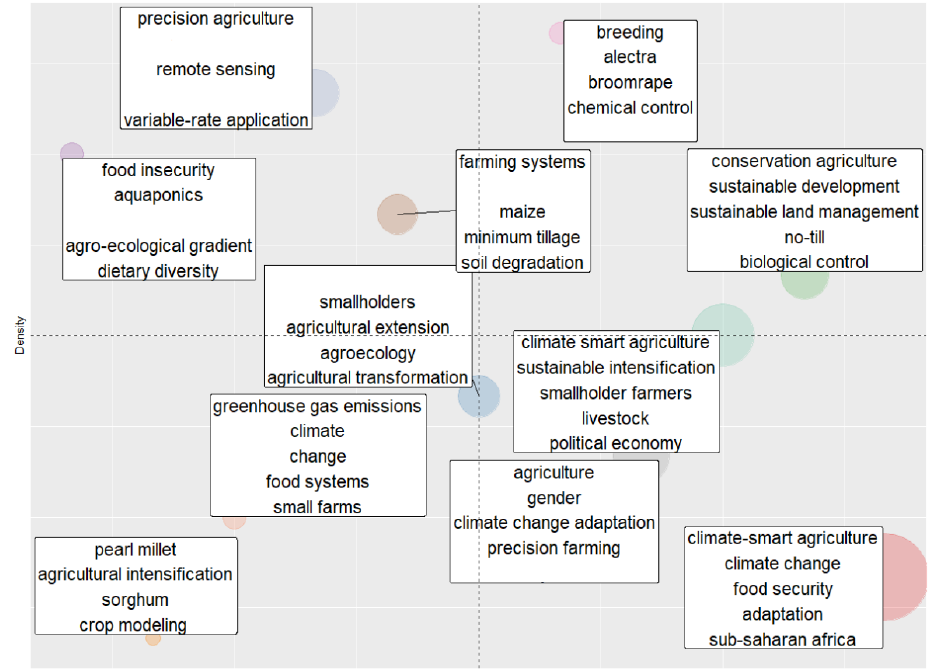
Figure 6. Thematic map of emerging themes in CSA